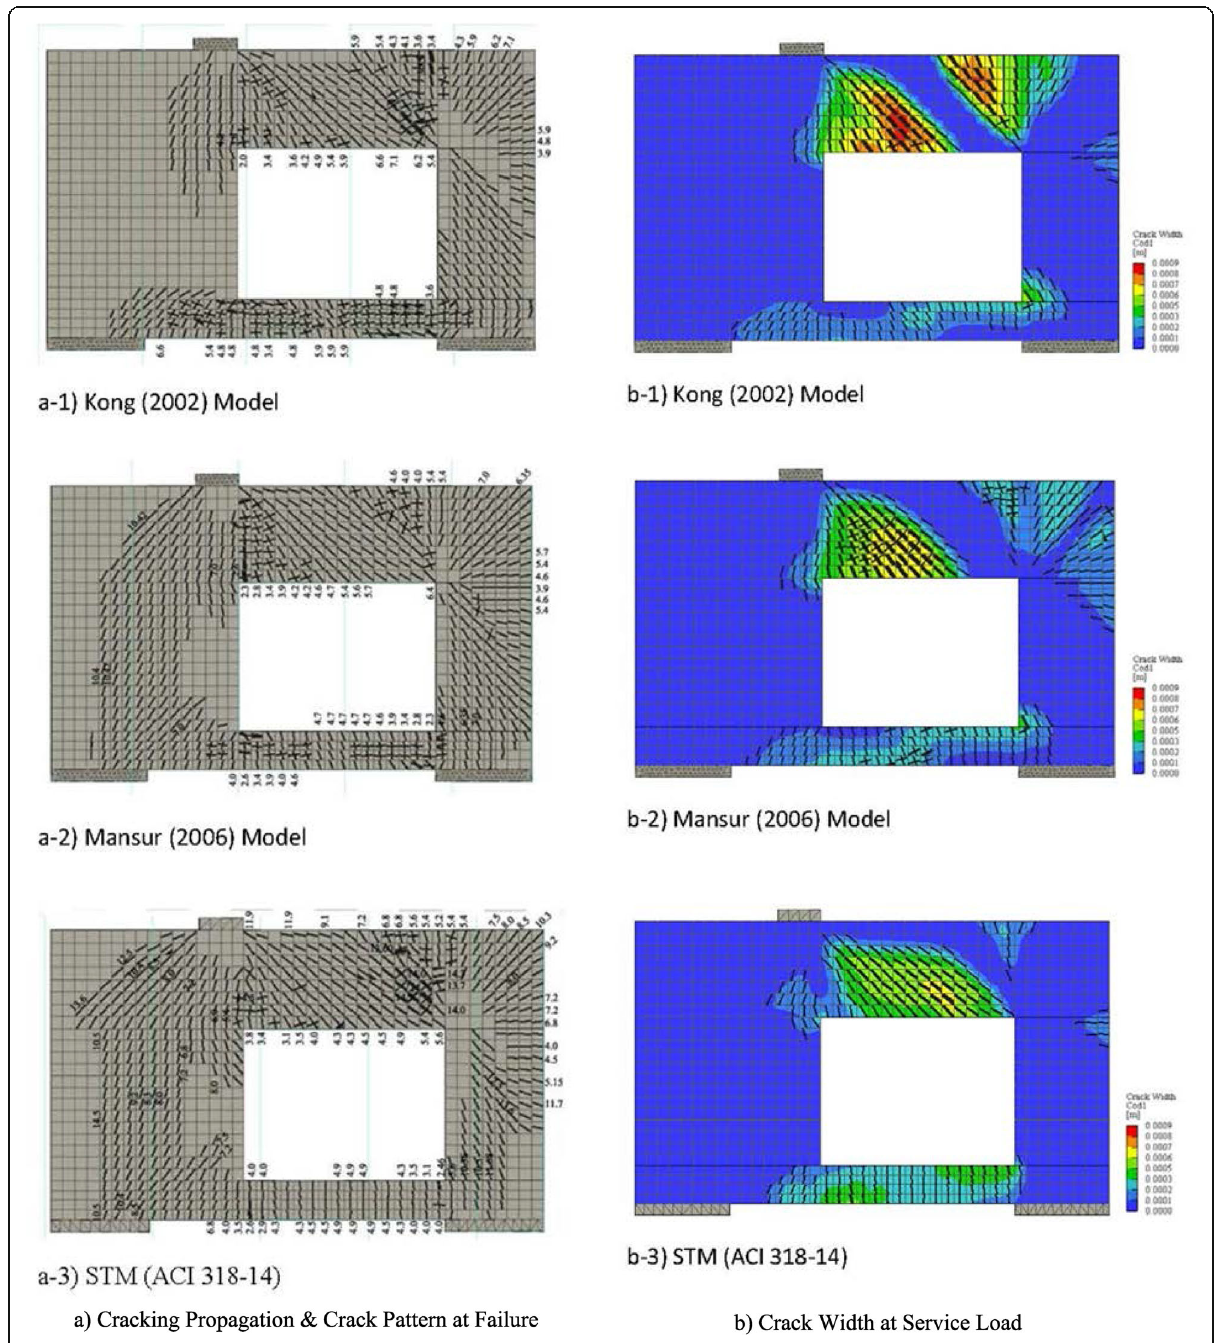
Fig. 8 a Cracking propagation and crack pattern at failure. b Crack width at service load